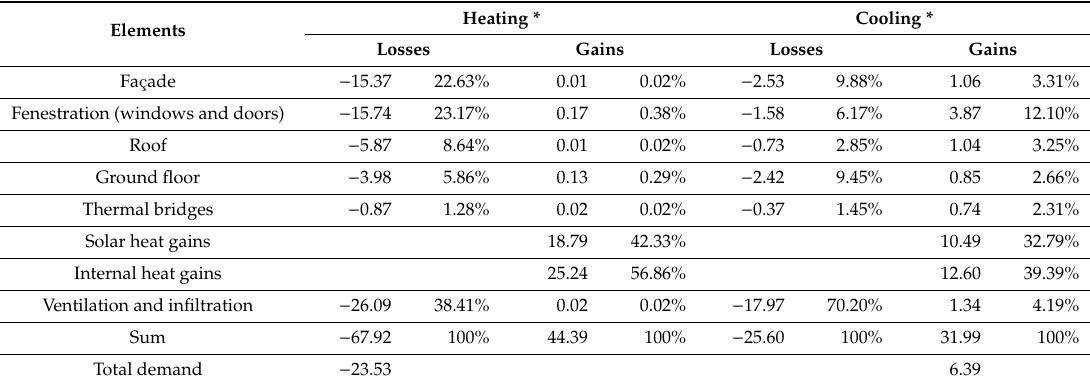
Table 12. Thermal balance. Example 2: Hypothesis 2, Model 4, Constructive solution 2, Climate Zone C2, Orientation West. Thickness 80mm, Insulation Material